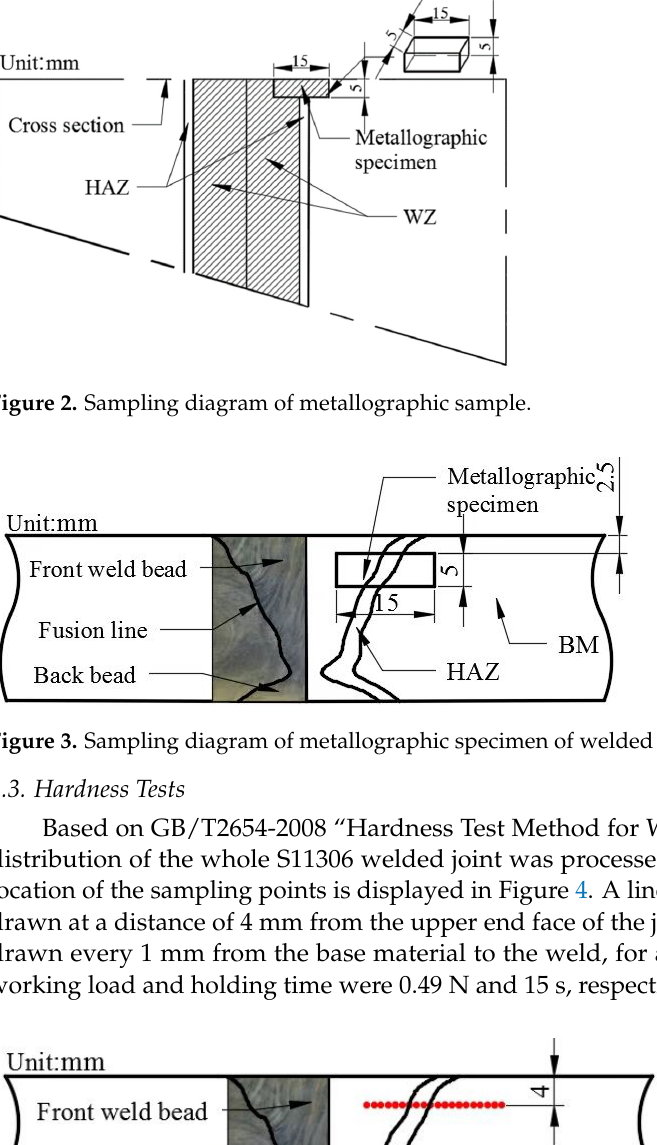
Figure 4. Sampling diagram of hardness test point of welded joint .